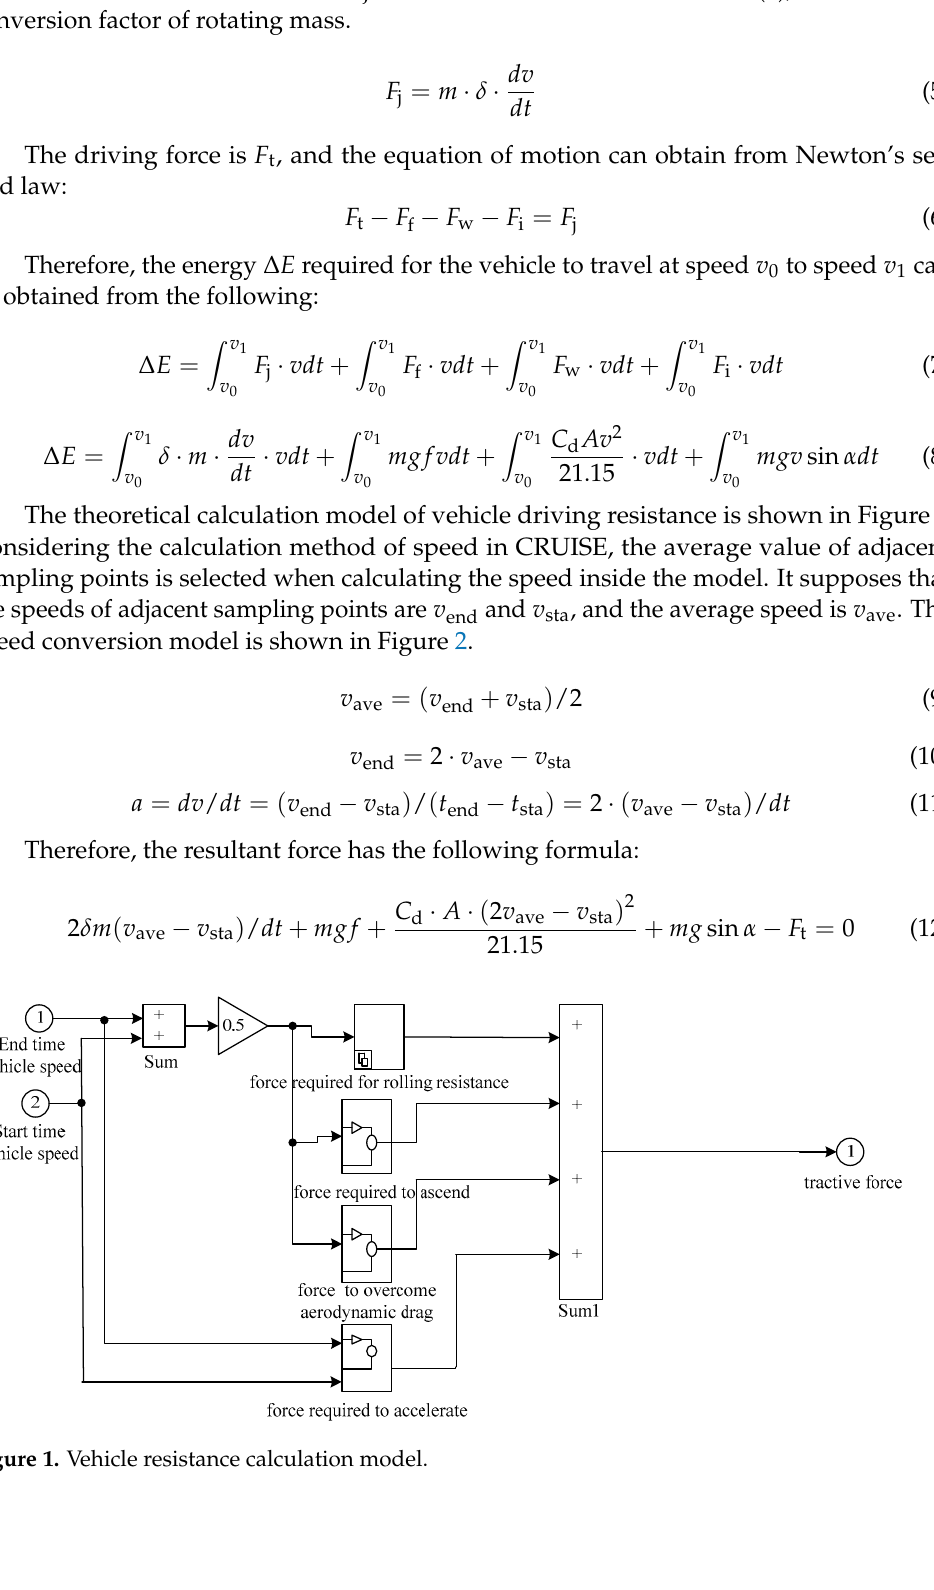
Figure 2. Speed calculation model. In the velocity calculation model: